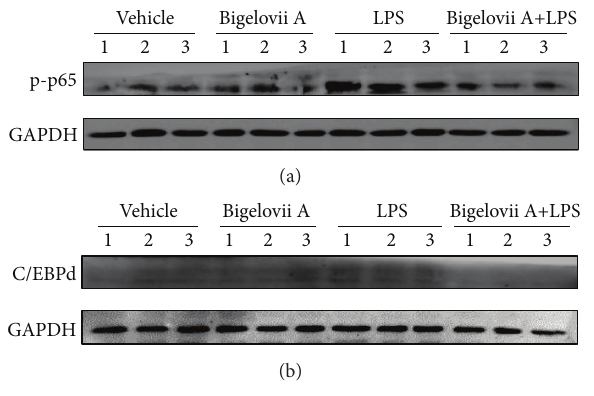
Figure 10: Effect of Bigelovii A on NF- 𝜅 B activation and C/EBP 𝛿 expression during LPS-induced acute lung injury. Lung injury was induced by intratracheal administration of LPS. 3h later, total proteins were extracted from whole lung tissues, and Western blot were performed by using antibodies against NF- 𝜅 B p-p65, C/EBP 𝛿 , and GAPDH, respectively. Mice receiving Vehicle and PBS treatment were considered as negative controls, and mice treated by Vehicle plus LPS were used as positive control.